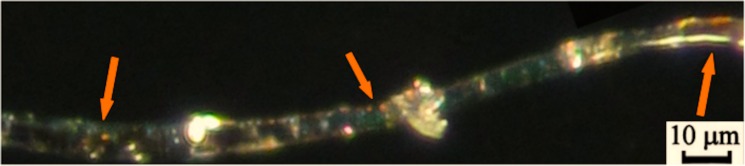
Light microscopy image.Low-magnification, light microscopy dark-field, epi-illumination image of a piece of fiber of the TS: the arrows indicate some of the red particles on the surface of the fiber recognized as blood [17].